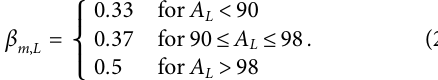
Frontiers in Physics |